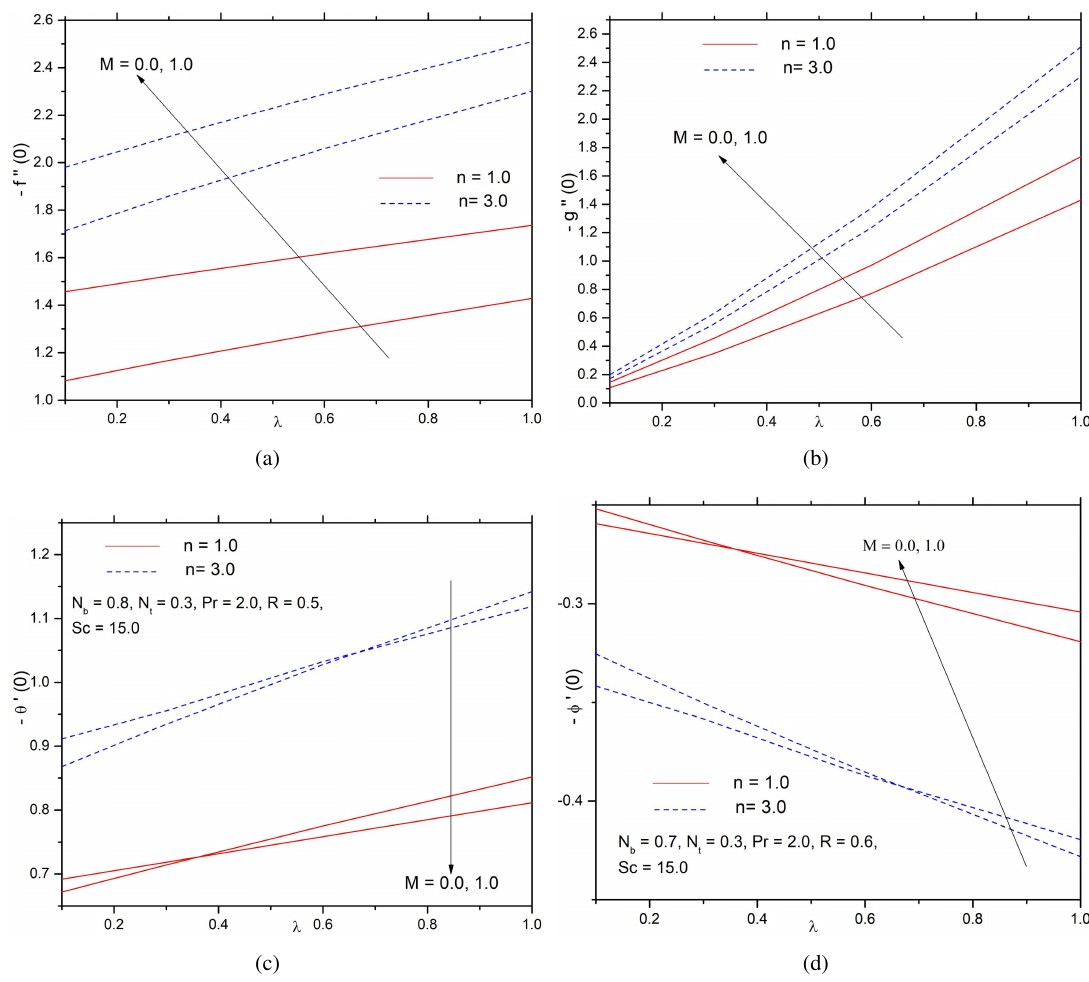
Fig. 11 Distributions of (a) − f (cid:48)(cid:48) (0) (b) − g (cid:48)(cid:48) (0) (c) − θ (cid:48) (0) [for CWT] (d) − ϕ (cid:48) (0) [for ZMF] with λ , stretching ratio parameter for diverse values of magnetic field parameter M